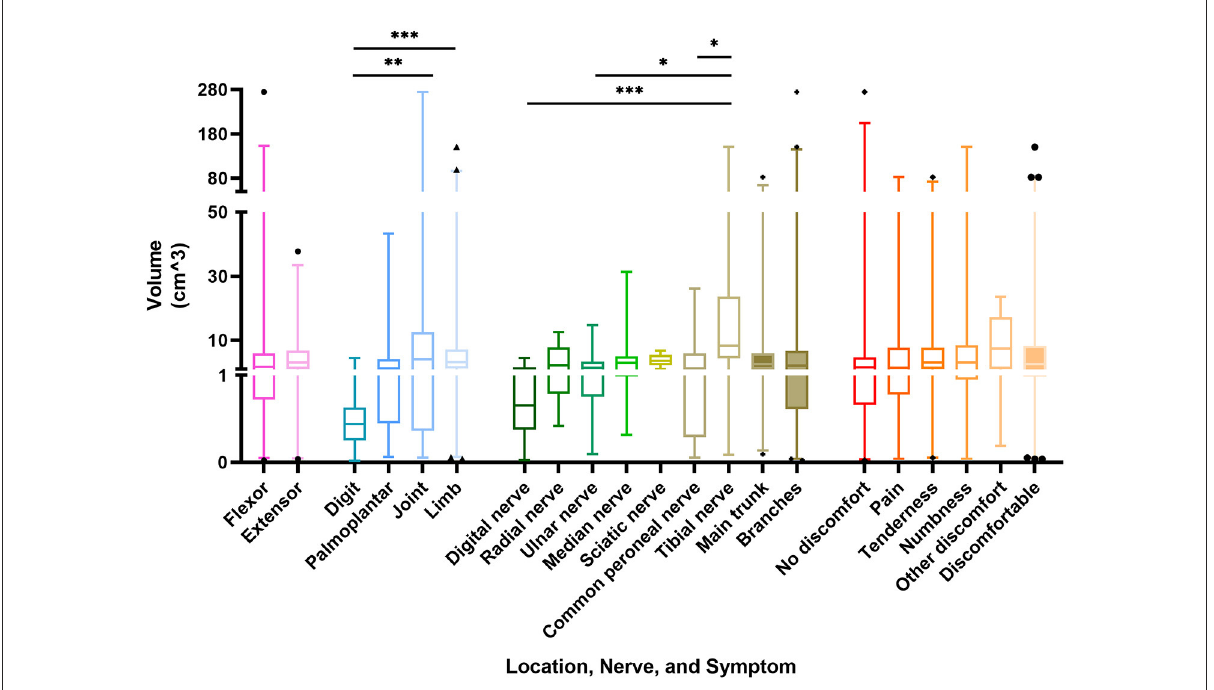
FIGURE3 Box plot representing the correlation between the volume of schwannomas and its location, nerve of origin, and symptoms. p -value * < 0.05, ** < 0.01, *** < 0.005.